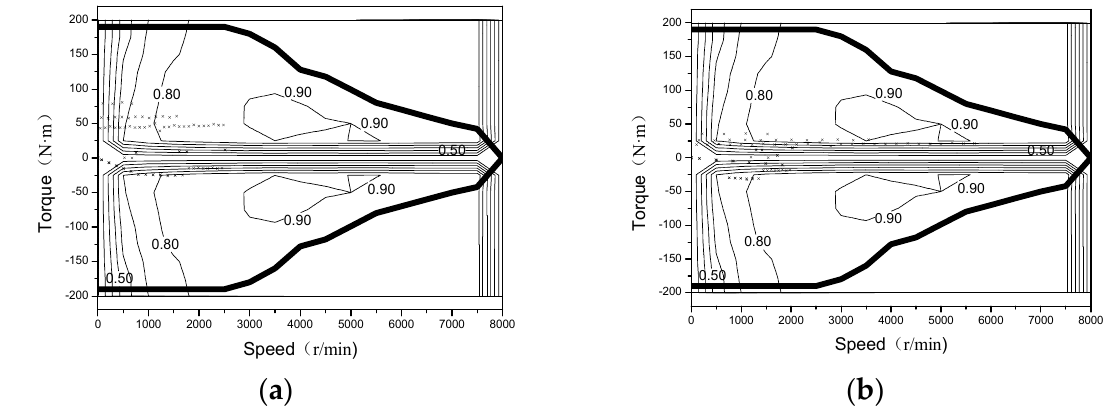
Figure 13. Motor operating point comparison (ECE). ( a ) Fixed ratio transmission. ( b ) Two-speed planetary transmission.